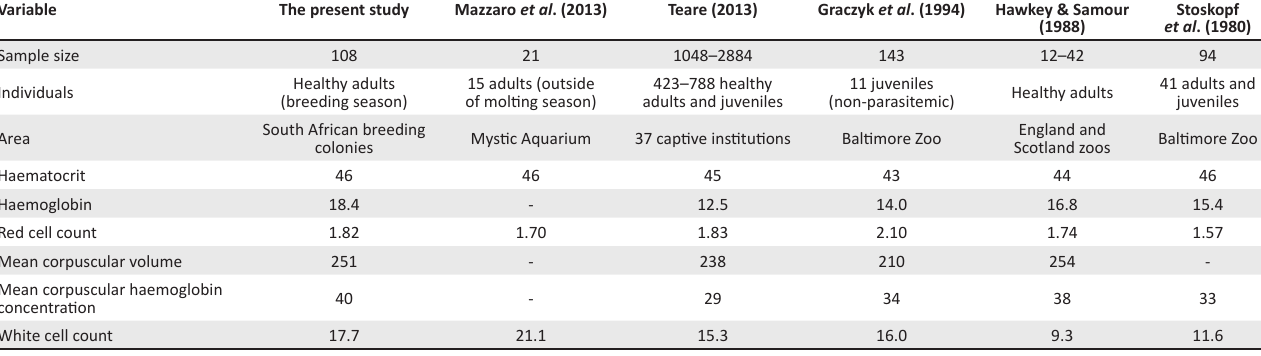
TABLE 4: Mean haematology values for the present study and previously published African penguin studies. Variable